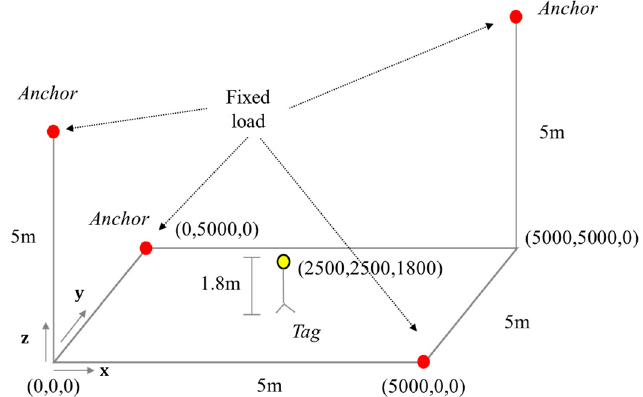
Figure 7. Anechoic chamber test (a yellow circle represents a tag and red circles represent anchors). Table 2. Measurement error for an immovable target.